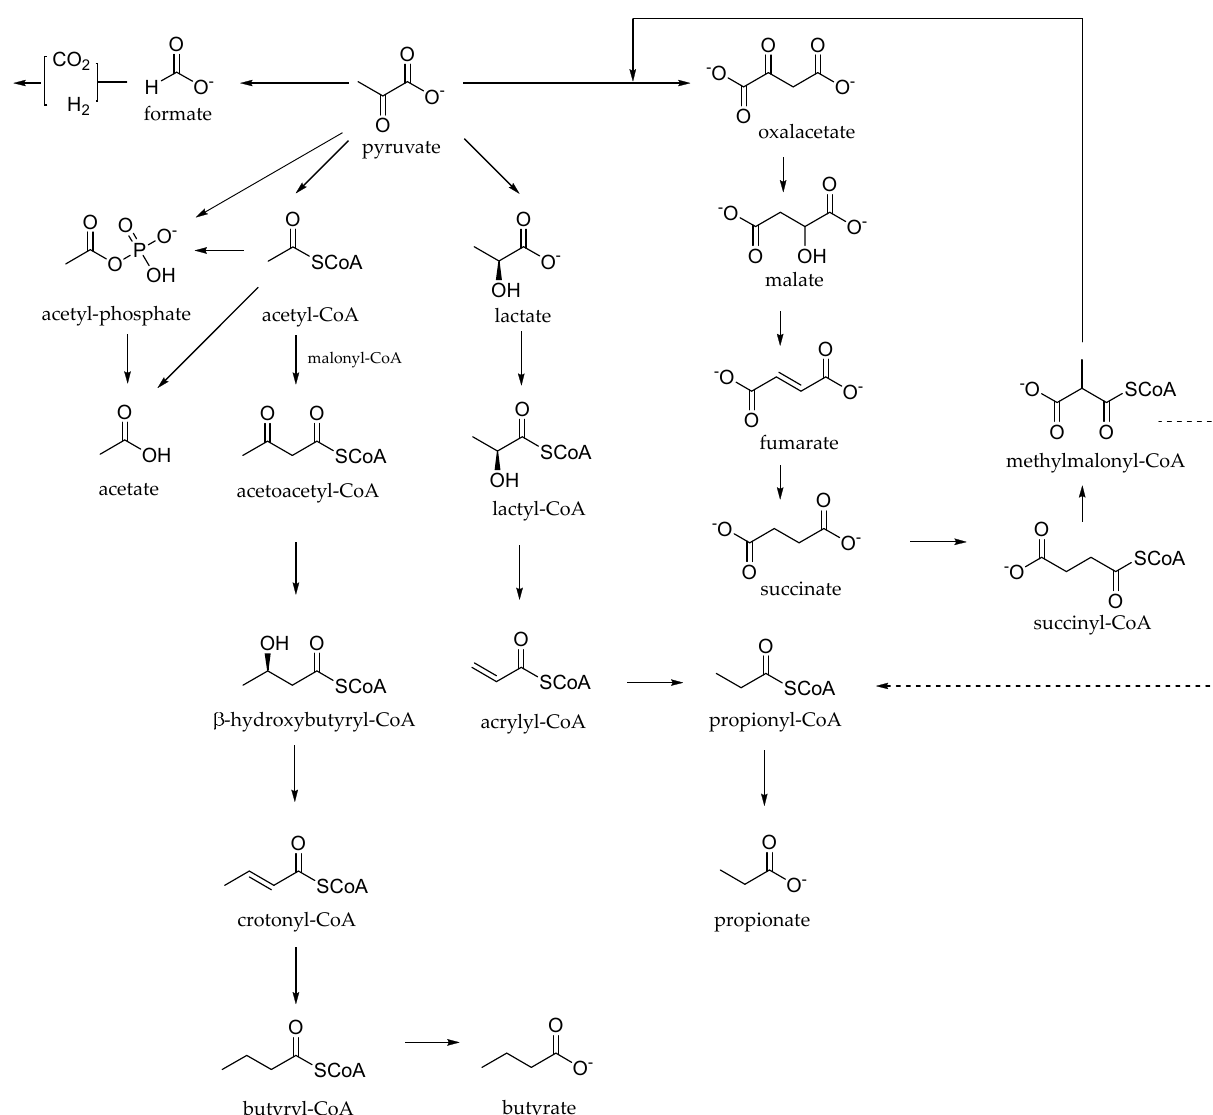
Figure 3. Main volatile fatty acids biosynthesized by microbes in ruminal fluid from pyruvate.